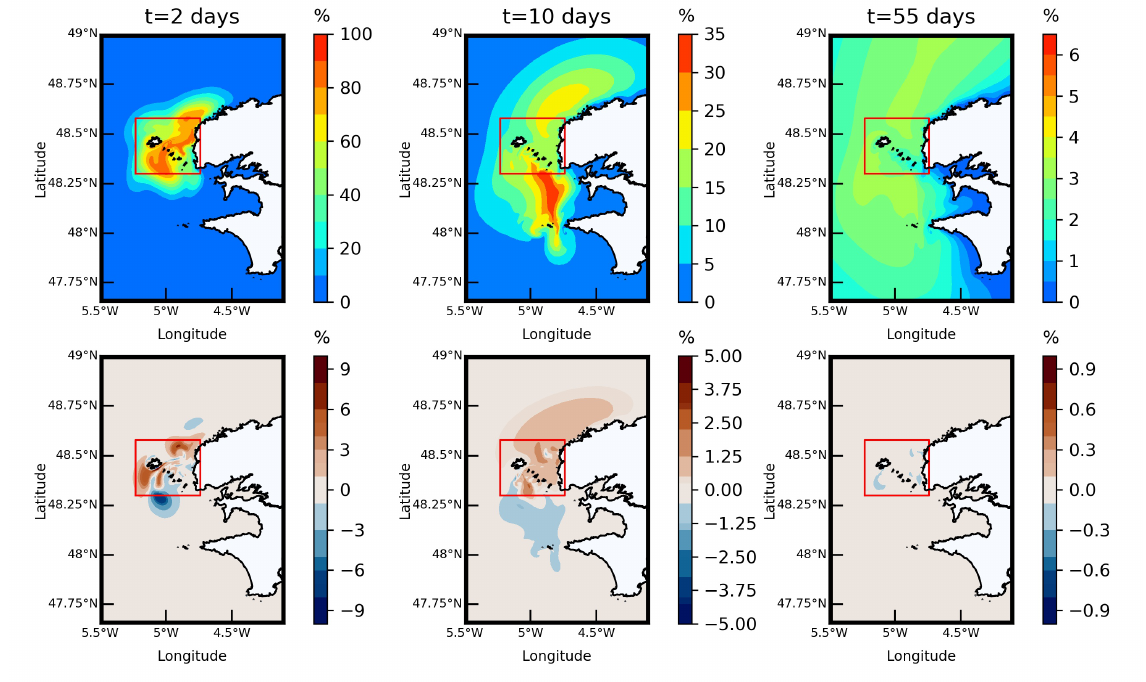
Figure 11. ( top ) Spatial distributions of the tracer concentration after 2, 10, and 55 days for an initial release at high tide of a M 2 tidal cycle within the control domain delimited with red line. Values are expressed in percentages of the initial tracer concentration imposed within the control domain and set to C ini = 1 m 3 m − 3 . ( bottom ) Spatial distributions of differences in tracer concentration between (i) the full energy extraction scenario and (ii) the baseline simulation without operating turbines. These differences are expressed in percentages of the initial tracer concentration C ini . Positive values account for an increase of the tracer concentration with turbines whereas negative values exhibit a decrease of the tracer concentration (adapted from